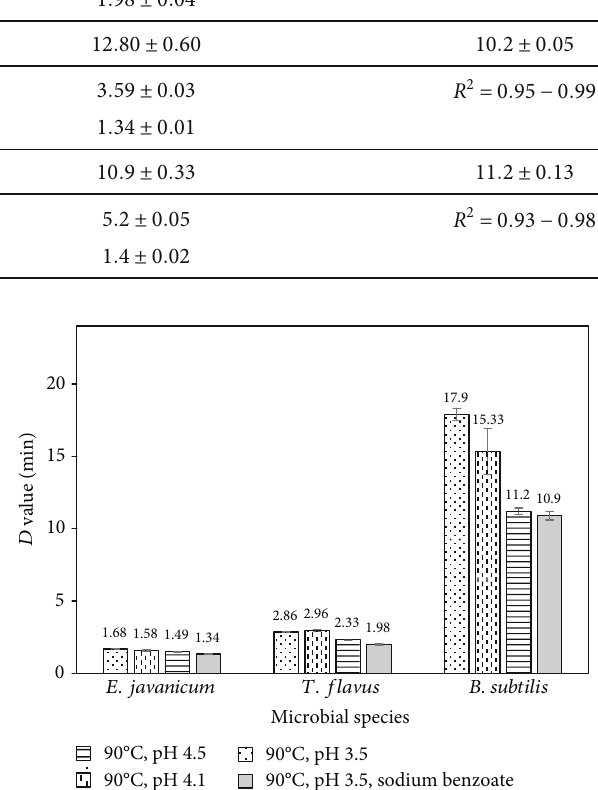
Figure 4: Comparison of decimal reduction values of Bacillus subtilis bacteria and Talaromyces fl avus and Eupenicillium javanicum molds in 11.4 ° Brix guava juice at 90 ° C (values are average ± standard deviation